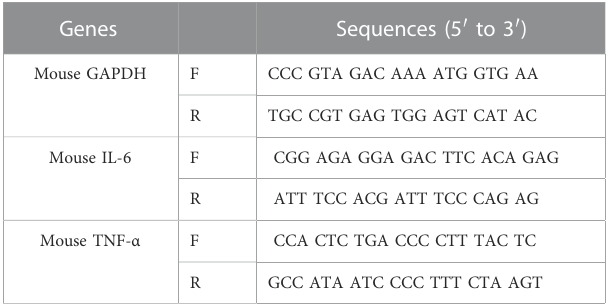
TABLE 1 Primers used for qRT-PCR.